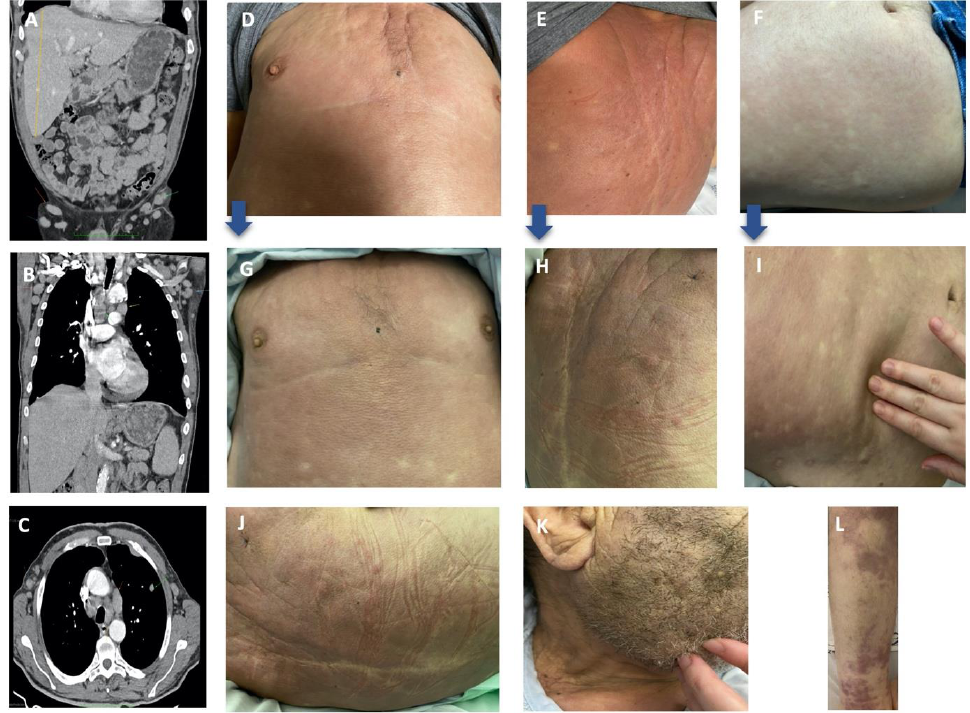
Figure 1. Imaging ( A – C ) and clinical ( D – I ) findings: ( A – C ) CT scan (axial and coronal reformations) showing hepatomegaly and lymphadenopathy (inguinal, axillary and mediastinal) with no splenomegaly. Noteworthy are the focal pleural thickening and pulmonary nodule (left upper lobe with 12 mm); ( D – F ) cutaneous examination shows diffuse erythema and skin thickening in upper trunk with scattered nodules; and ( G – I ) marked cutaneous infiltration with progressive aggravation of the skin thickening on the upper trunk. Blue arrows show the evolution in the images from top to bottom; clinical aggravation with marked cutaneous infiltration with aggravated skin thickening in upper and lower trunk ( J ), neck ( K ) and new purple patches on lower limb ( L ). Bone marrow evaluation and excisional axillary adenopathy biopsy were performed. The flow cytometry was inconclusive, showing a lack of lineage specificity with CD11c+, CD33+, CD64+ (low), myeloperoxidase (MPO)+ (dubious) and HLA-DR. Bone marrow morphology showed massive infiltration but no clear conclusions due to the extensive immaturity and the aberrant cell morphology (Figure 2C). The patient remained hemody- namically stable with no aggravating symptoms, and he was discharged while awaiting histological results and was closely evaluated as an outpatient. A methylprednisolone pulse regimen (500 mg IV daily for 3 consecutive days) was implemented with no obvious improvement. In the following days, rapid deterioration occurred with asthenia, diffuse skin thickening in the upper trunk, and the appearance of multiple nodules in the neck and upper trunk (Figure 1G–I). Nodules ranged between 1 and 2 cm, were firm in con- sistency and were non-tender. Following a skin biopsy, the patient was admitted to symp- tom control. On the 19th day after clinical onset, the bone marrow biopsy was compatible with AML, revealing extensive infiltration by blast cells with a morphology identical to